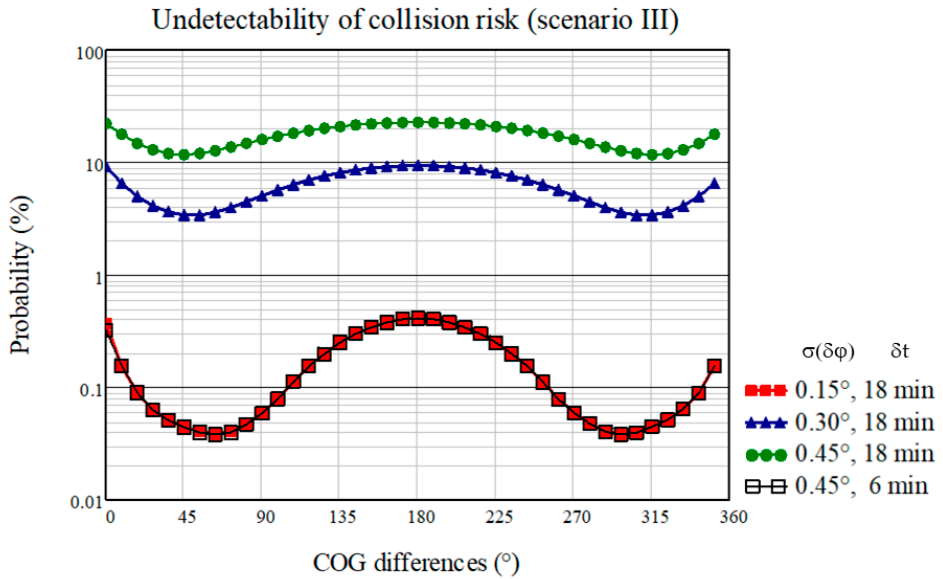
Figure 11. Impact of course-over-ground (COG) inaccuracies on the probability of undetected collisions risks dependent on COG differences ϕ A - ϕ B between both ships (L = 100 m, provided for selected forecast times δ t, equally distributed SOG values between 0 and 25 kn and standard deviations σ ( δϕ A ) = σ ( δϕ B ) = σ ( δϕ ) of COG inaccuracies).